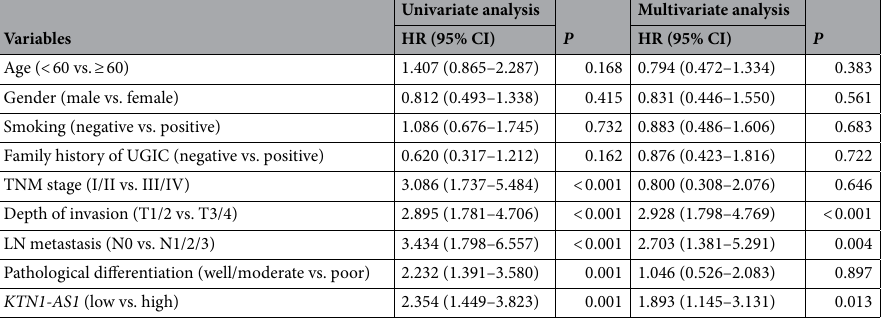
Table 2. Univariate and multivariate Cox regression analysis for clinicopathological features with prognosis of patients with ESCC.